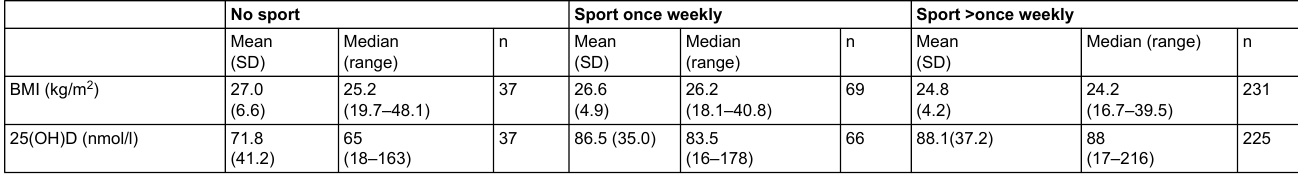
BMI = body mass index; SD = standard